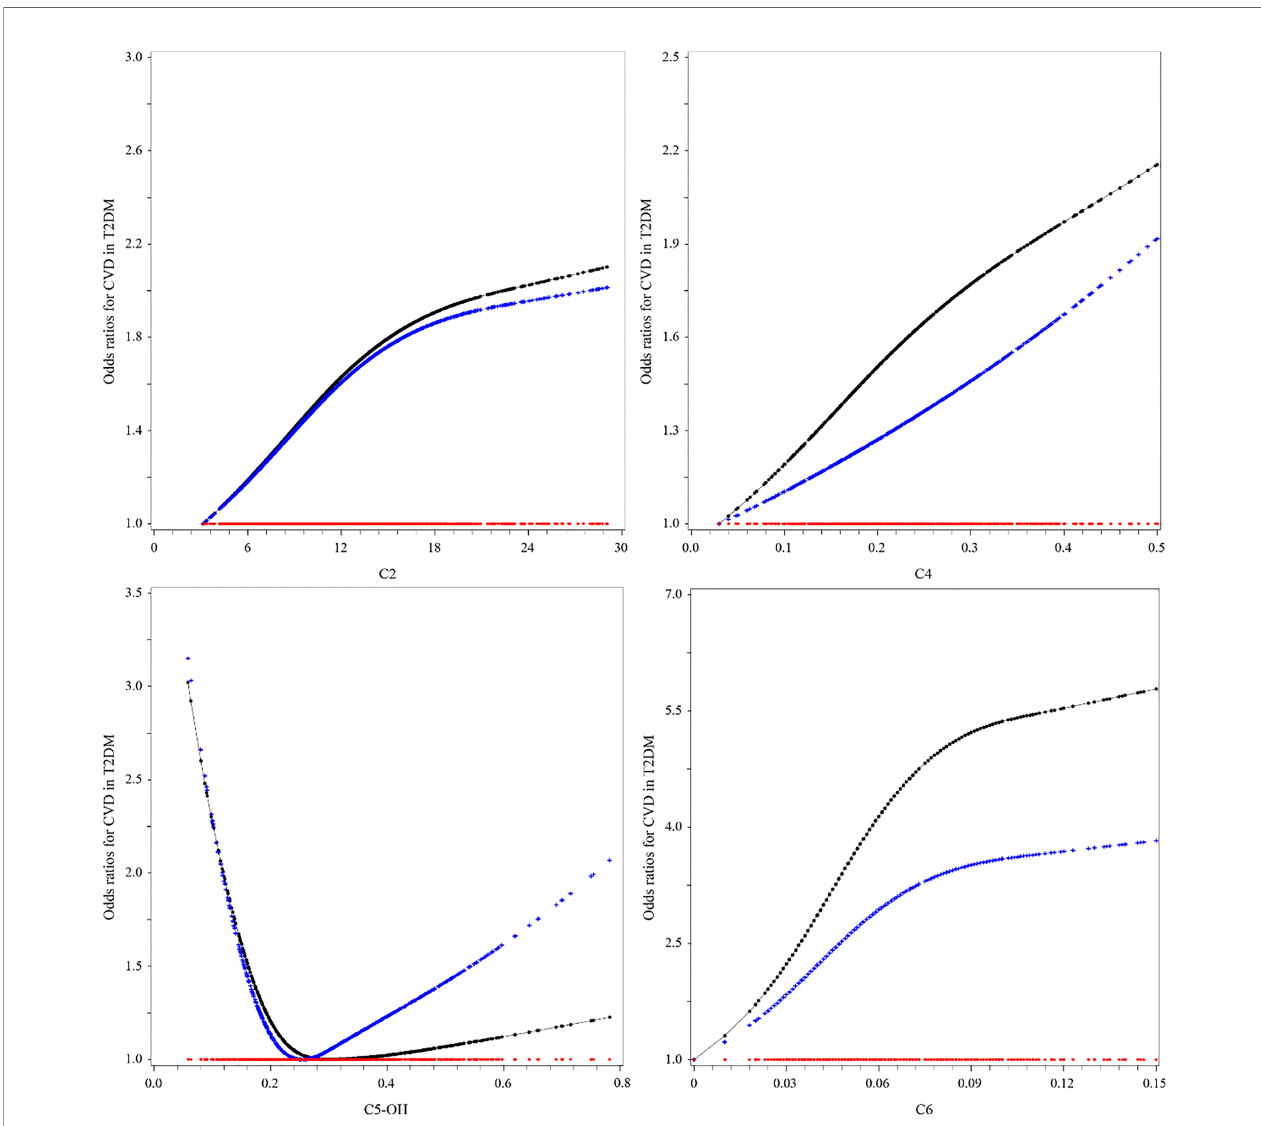
FIGURE 1 | Associations between short-chain acylcarnitine and the risk of cardiovascular disease (CVD) in type 2 diabetes mellitus (T2DM). The black lines were derived from univariable model 1, the blue lines from multivariable analyses (see Table 3 , multivariable model 2, for the list of adjusted variables), and the red lines were the reference lines at OR =